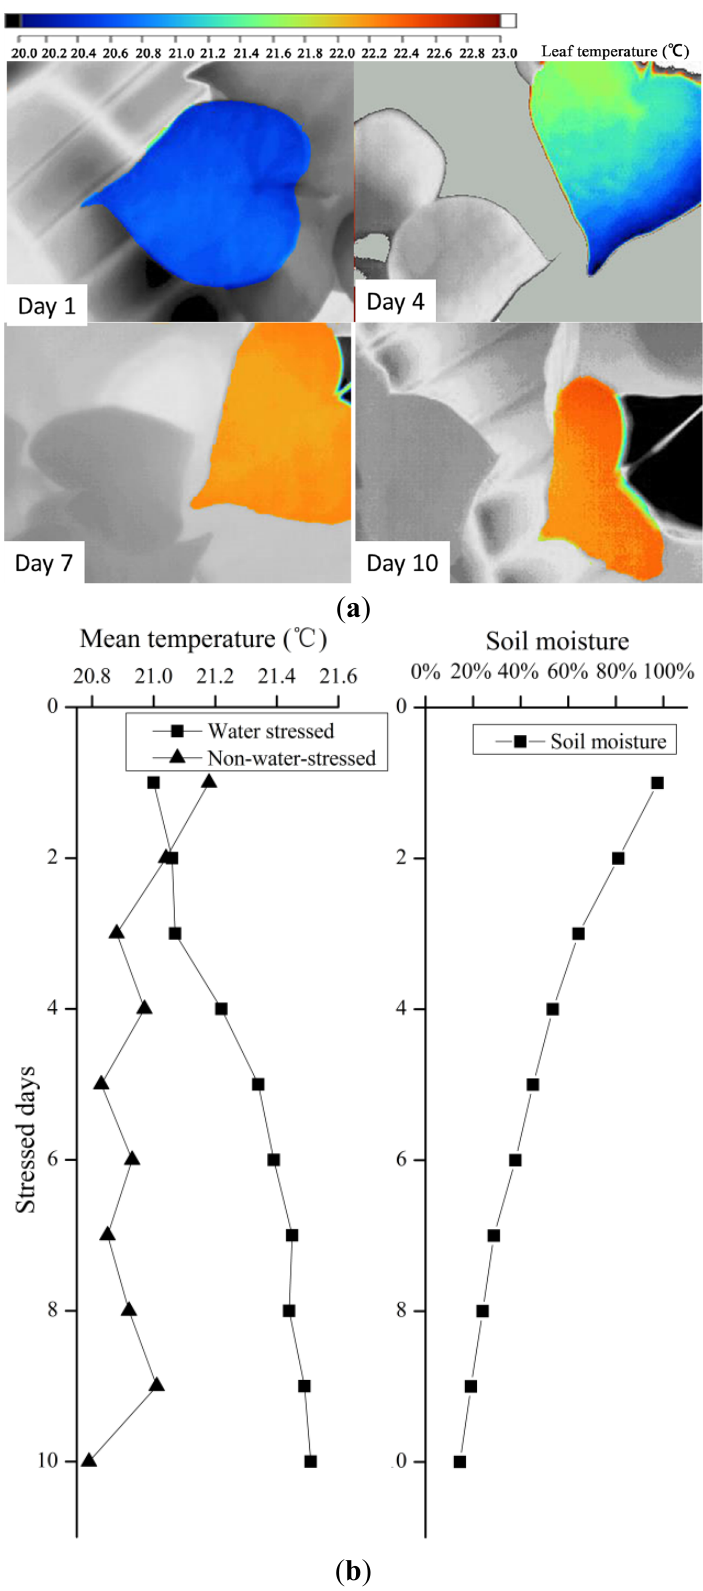
Figure 4. Individual leaf thermal temperature dynamics during consistent water deficit. ( a ) Four days are selected to indicate the change of the same leaf during the experimental period. ( b ) The mean leaf temperature dynamic during the experiment with soil moisture decreasing; the temperature of a non-water stressed leaf is also presented for